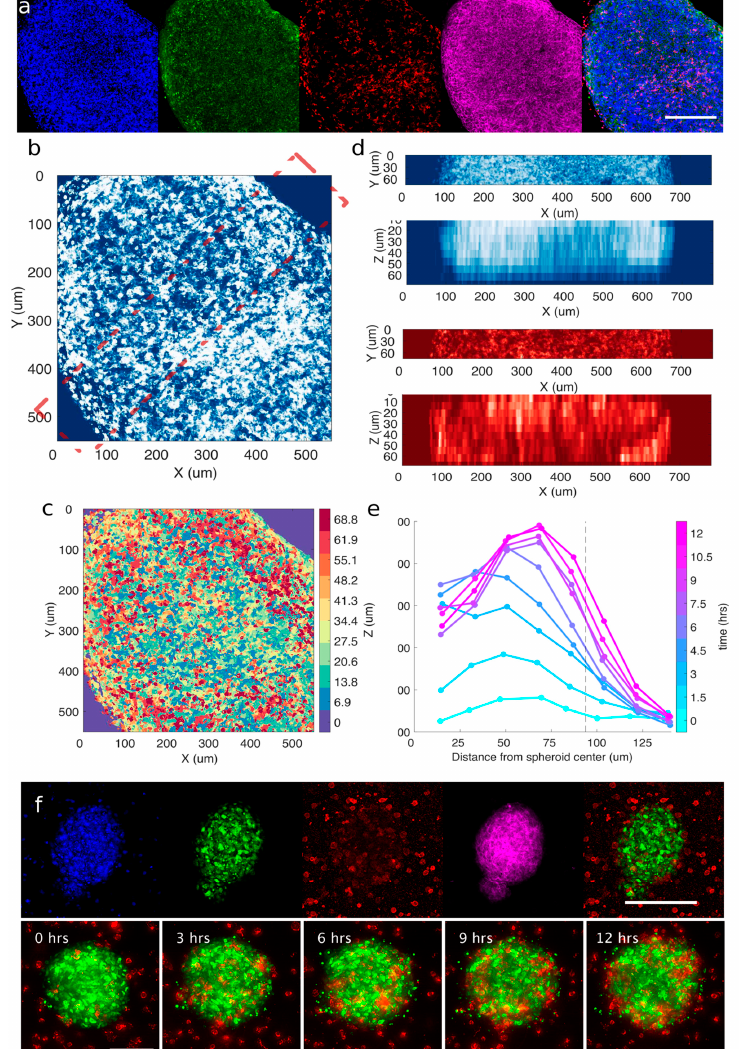
Figure 3. Effectors are infiltrating the tumor masses. ( a ) Representative single confocal section of a mMel2 spheroid challenged with CIK after 70 h. (blue: dapi; green: anti-caspase 3; red: CD45; magenta: phalloidin; mixed: merge of dapi, CD45, and caspase). Scale bar: 200 µ m. ( b ) Maximum intensity projection of confocal sections from data set shown in panel ( a ). False colors go from low intensity (dark blue) to high intensity (white). ( c ) Maximum intensity projection of confocal sections from data set shown in panel ( a ), with color coding corresponding to height of each pixel. Color bar on the right of the image shows the different colors used to identify planes from the stack. ( d ) Projections of data set shown in panel ( a ), sliced according to the dashed, red mark shown in panel ( b ). Top (bottom) rows correspond to xy (xz) maximum intensity projection for dapi signal (white on blue) or CD45 (white on red). ( e ) Radial profiles of recruitment (fluorescence intensity) were obtained by averaging radially the fluorescence signal. Each line represents a time, as indicated in the color bar. The dashed, black line represents the boundary of the spheroid. ( f ) Top: representative, single confocal section of a M005 spheroid challenged with NK-92 after 50 h. (blue: dapi; green: H2B-GFP; red: CD45; magenta: phalloidin; mixed: merge of H2B-GFP and CD45). Scale bar: 200 µ m. Bottom: time sequence of a time-lapse experiment with mMel2-H2BGFP (green) and NK-92 (red). Images are maximum intensity projections of deconvolved images. Scale bar: 100 µ